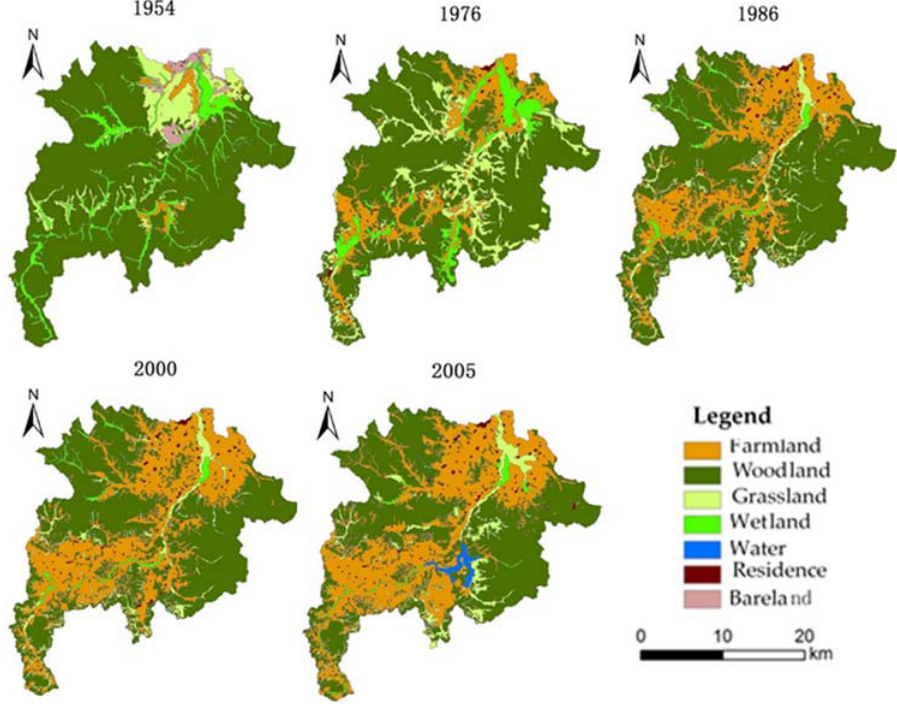
Figure 3. Charts of land use in the upper Naoli River watershed during 1954–2005.